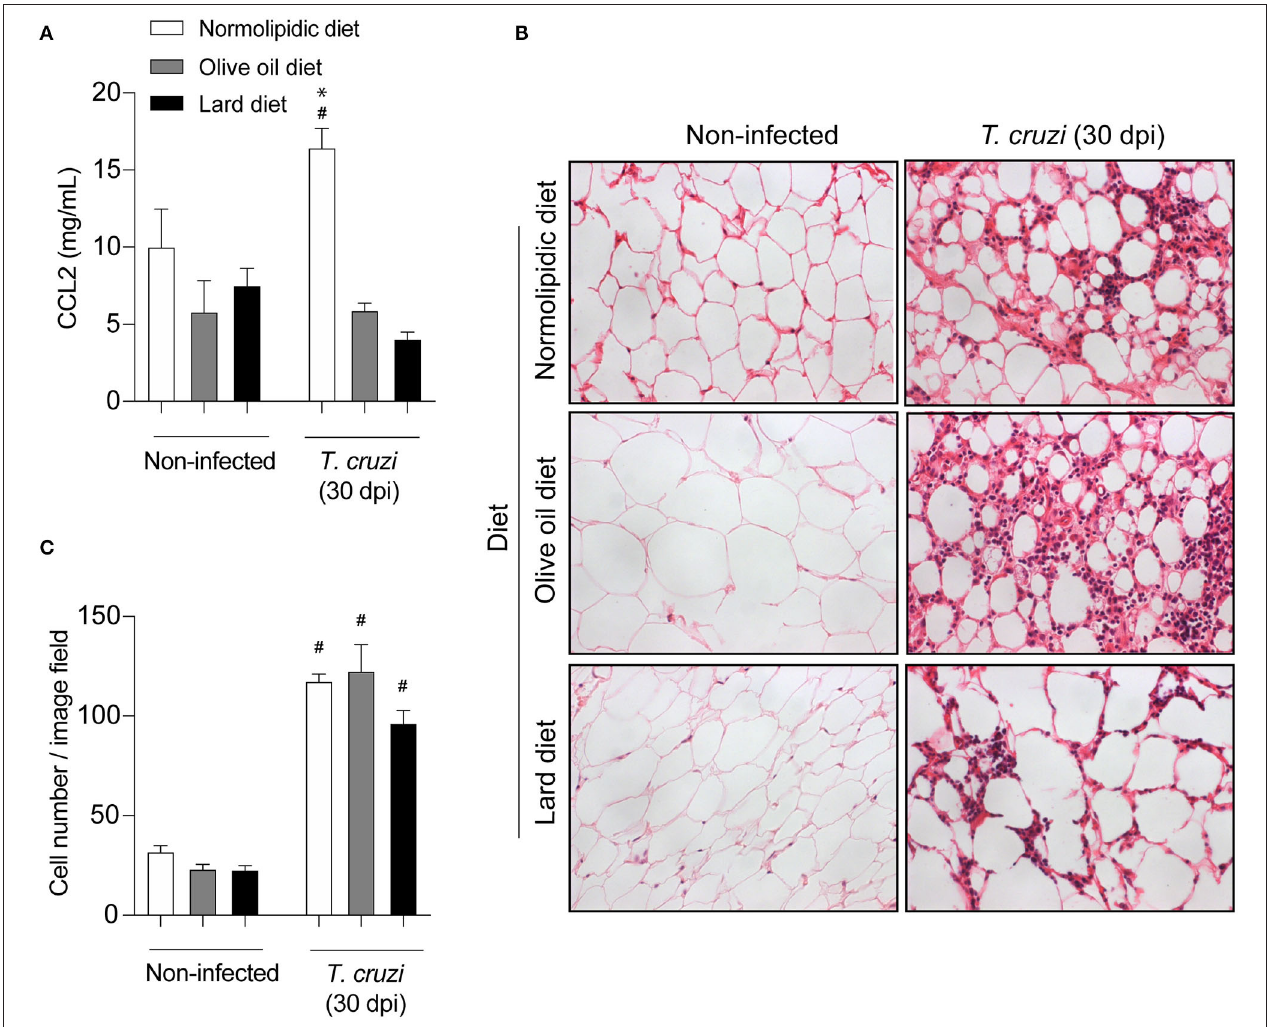
FIGURE 4 | Adipose tissue inflammatory parameters of T. cruzi infected mice fed with different types of hyperlipidic diets. Newly weaned C57BL/6 mice were fed with either a normolipidic diet ( n = 8), monounsaturated fatty acid diet with olive oil ( n = 8) or saturated fatty acid diet with lard ( n = 8). At the day 60 of diet, mice were intraperitoneally infected with 50 blood trypomastigote forms of T. cruzi Colombian strain. After 30 dpi (A) the concentration of CCL2 was assessed in the adipose tissue by ELISA assay. (B) The adipose tissue was fixed, processed, blocked in paraffin, cut, and stained with hematoxylin and eosin and (C) the number of cells in the tissue was quantified. # p < 0.05 compared with the non-infected group and * p < 0.05 compared with infected olive oil and lard diets by one-way ANOVA followed by Tukey post-hoc